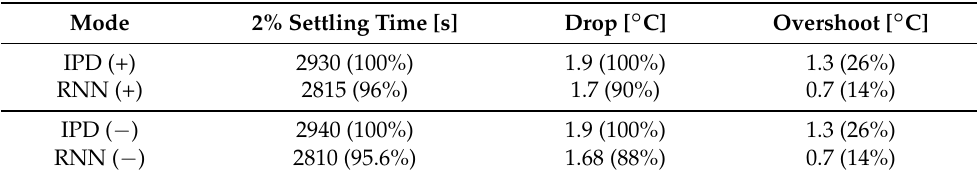
Table 3. Response characteristics after adding the disturbance signal. The drop and overshoot values represent the maximum offsets of the temperature variations in rising and falling processes, respectively. Experiment results are expressed as percentages, which values are based on that of the conventional method